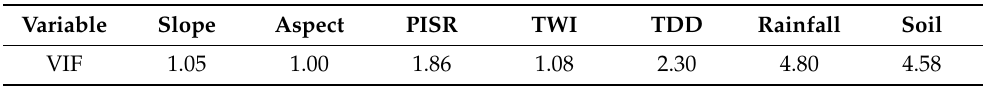
Figure 6. Pearson’s correlations between environmental conditioning variables (i.e., soil, rainfall, TDD, TWI, PISR, aspect, and slope). Table 2. The multicollinearity diagnosis indexes for all environmental variables (i.e., soil, rainfall, TDD, TWI, PISR, aspect, and slope).